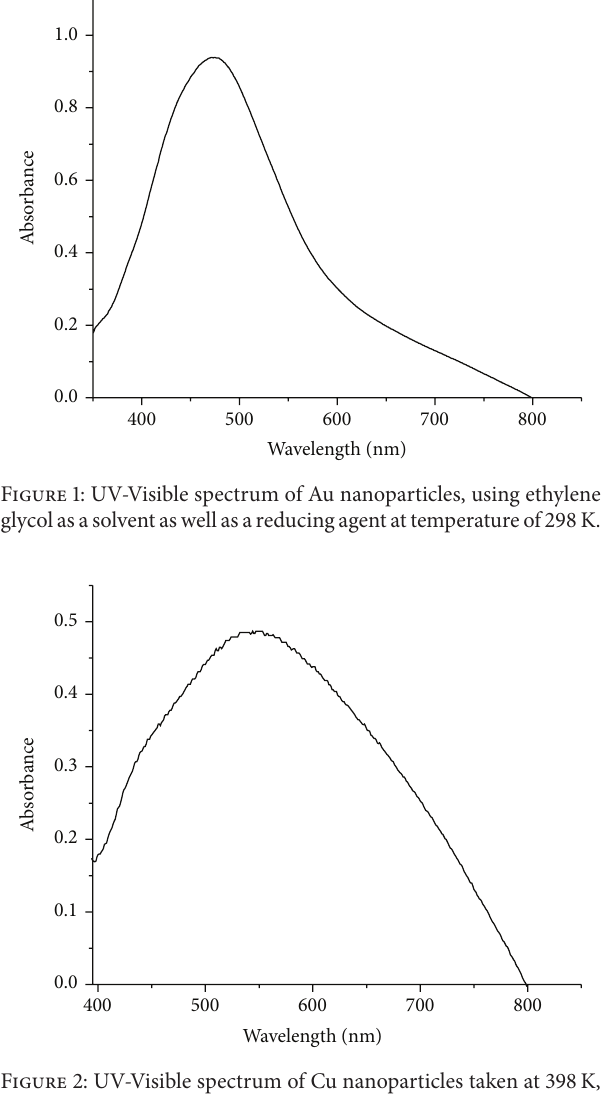
Figure 2: UV-Visible spectrum of Cu nanoparticles taken at 398 K, using ethylene glycol as a solvent as well as a reducing